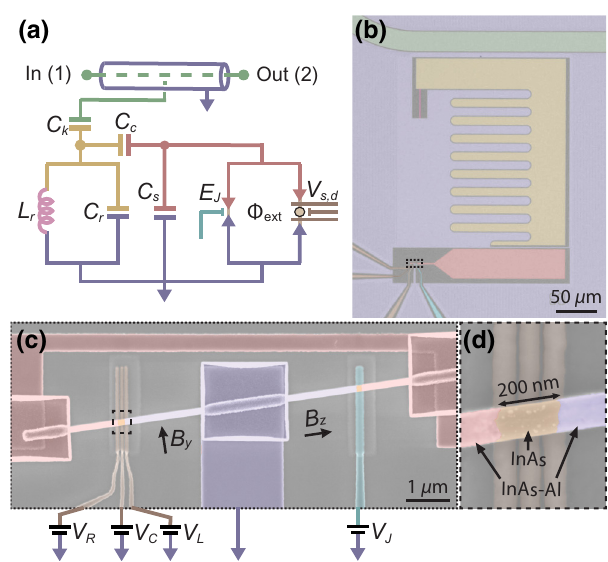
FIG. 2. The device overview. (a) A diagram of the microwave circuit. A coplanar waveguide transmission line (green center conductor) is capacitively coupled to a grounded LC resonator. The resonator consists of an island (yellow) capacitively and inductively (pink) shunted to ground (blue). The resonator is in turn capacitively coupled to a transmon island (red), which is shunted to ground capacitively as well as via two parallel Joseph- son junctions. (b) A false-colored optical microscope image of device A, showing the qubit island, the resonator island, the res- onator inductor, the transmission line, the electrostatic gates, and ground. (c) A false-colored scanning electron micrograph (SEM) of the Josephson junctions of the transmon, showing the InAs-Al nanowire into which the junctions are defined. The B y compo- nent of the magnetic field is used to tune (cid:5) ext [60]. B z is the magnetic field component parallel to the nanowire. (d) A false- colored SEM of the quantum dot junction in which the quantum dot is gate defined. The three bottom gates have a width and spac- ing of 40 nm, although this is obfuscated by the dielectric layer placed on top